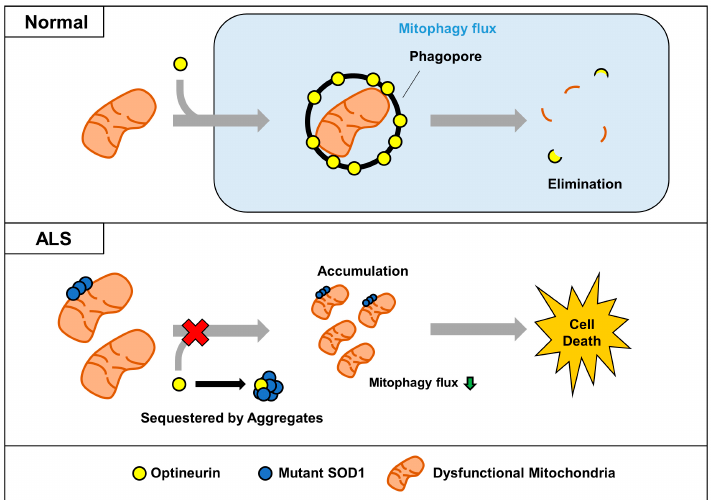
Figure 6. Proposed model for impairment of OPTN-mediated mitophagy by mutant SOD1 aggregates. In normal cells, dysfunctional mitochondria can be captured by the mitophagy receptor OPTN, and removed together. However, sequestered OPTN by SOD1 aggregates cannot be translocated to dysfunctional mitochondria, and this leads to the abnormal accumulation seen in ALS.